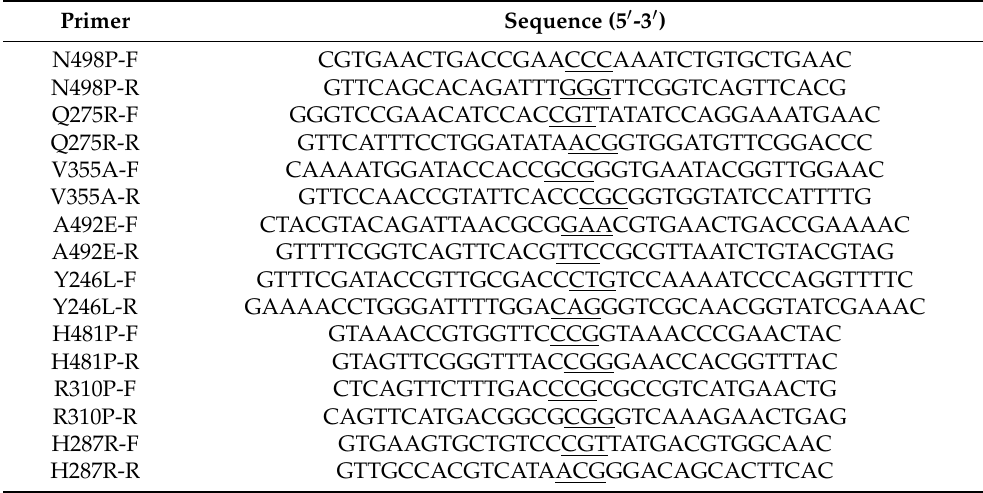
Table 1. The designed primers for mutation site.